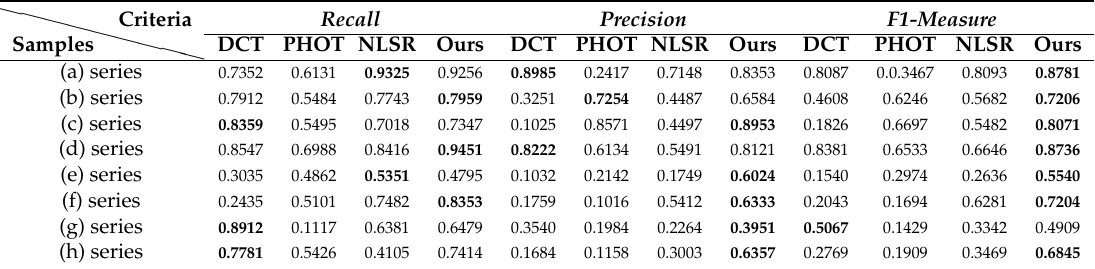
Table 3. Comparison of quantitative pixel-level segmentation results obtained with different methods for various textural sample series (each series contains 20 samples with real or synthetic defects).